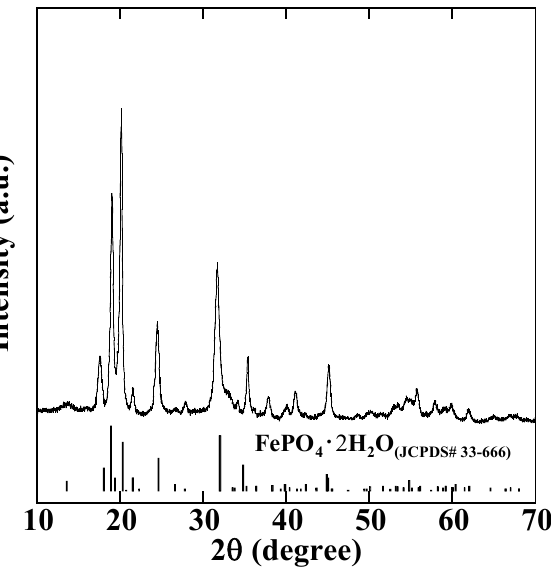
Figure 2. XRD pattern of solid particles synthesized by co- precipitation from a solution containing P(V) and Fe(III), with reference phosphosiderite data.